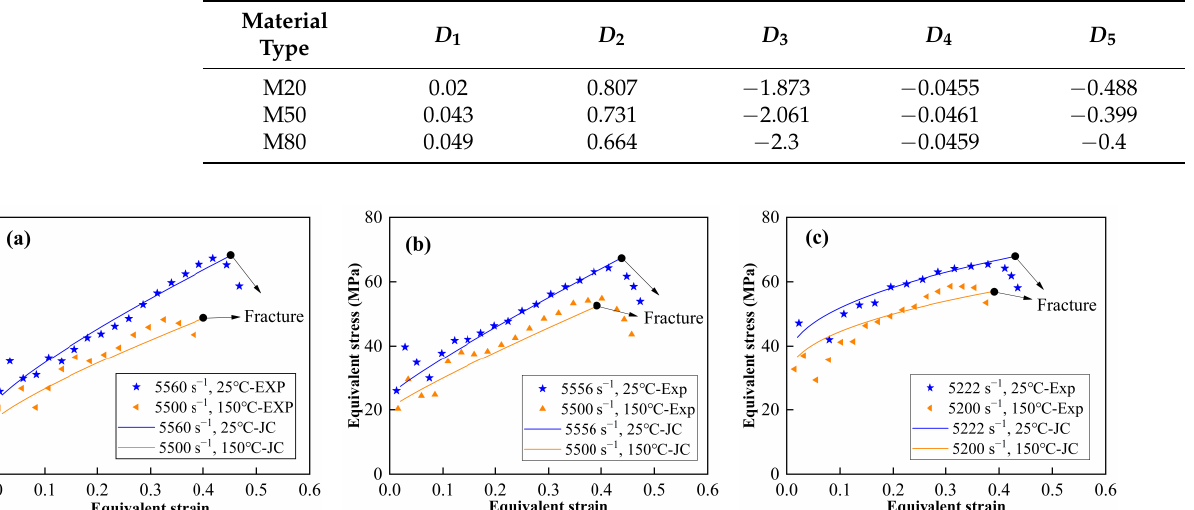
Table 6. Johnson–Cook failure parameters of the materials.